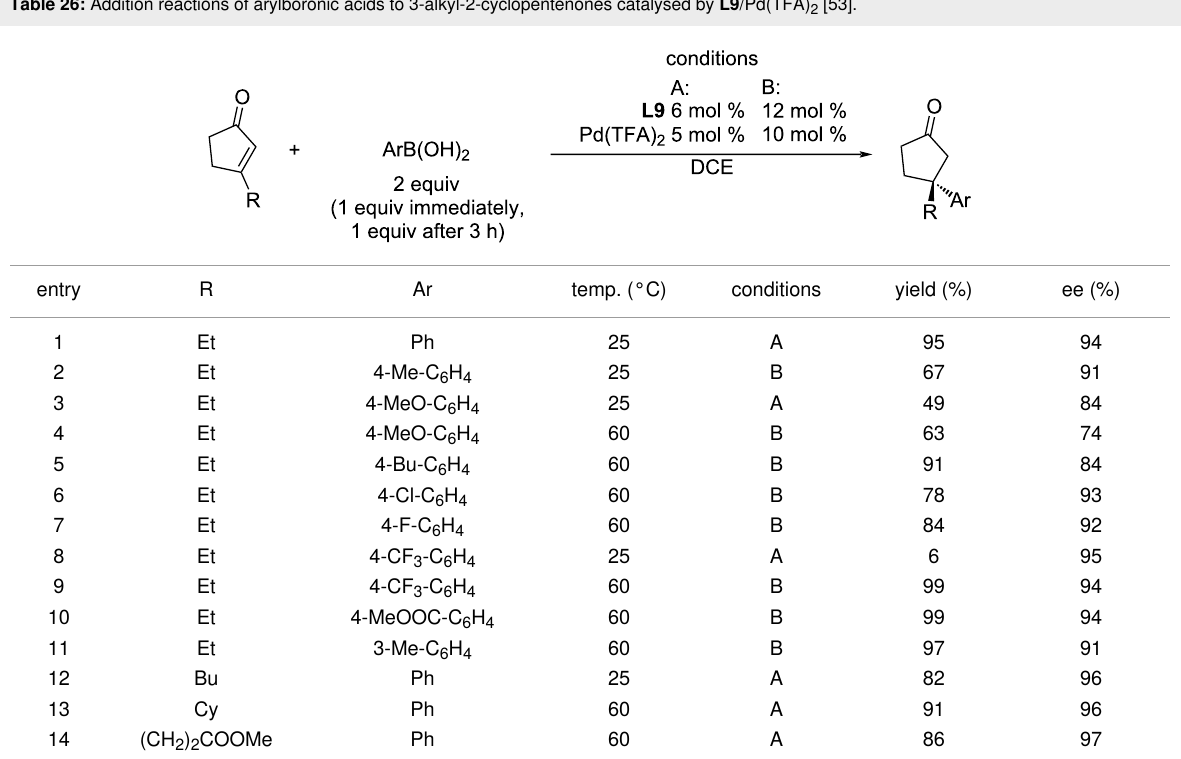
Table 26: Addition reactions of arylboronic acids to 3-alkyl-2-cyclopentenones catalysed by L9 /Pd(TFA) 2